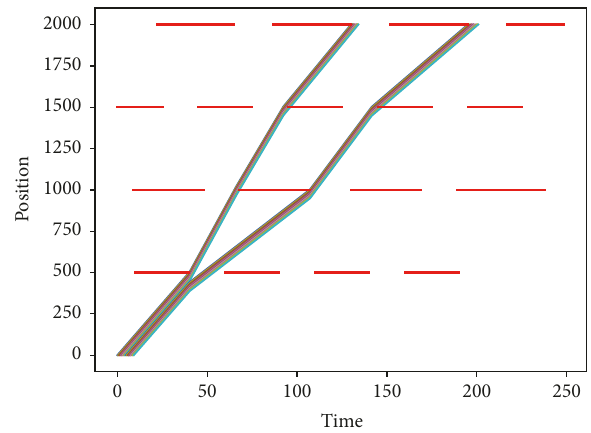
Figure 9: Vehicles’ trajectory of platoon with separation strategy ( maximum passing velocity